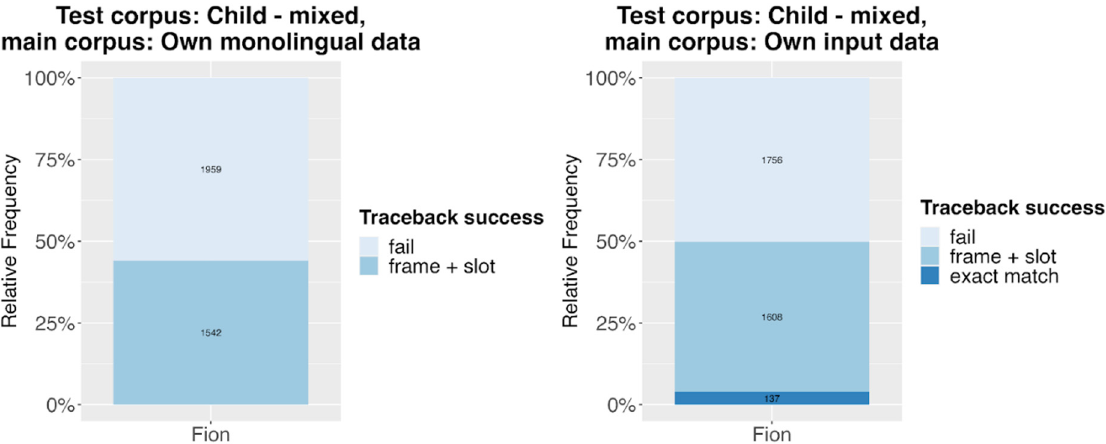
Figure 3. TB results. Fion’s code-mixed data traced back to his monolingual data and to the input. Figure adapted from Quick and Hartmann (2021).